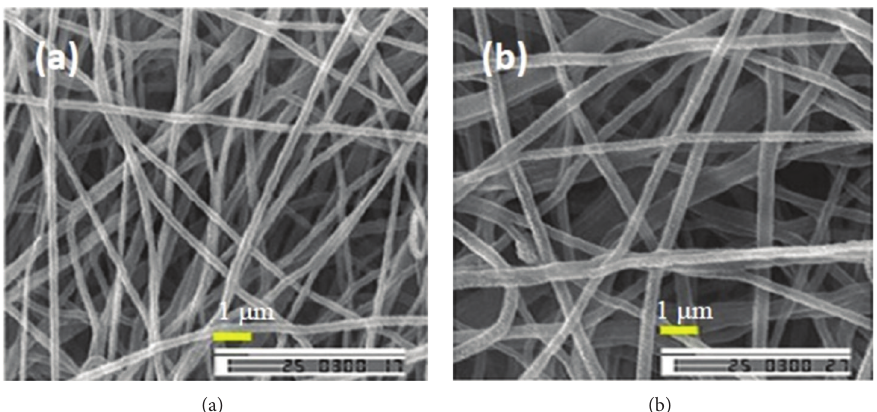
Figure 13: SEM micrographs of a polypyrrole electrospun nanofibers, formed from aqueous solutions of 1.5wt% poly(ethylene oxide) as carrier, with (a) and without (b) 0.5 wt% Triton X-100 surfactant. The polypyrrole content of the nanofibers is 71.5 wt% [91].